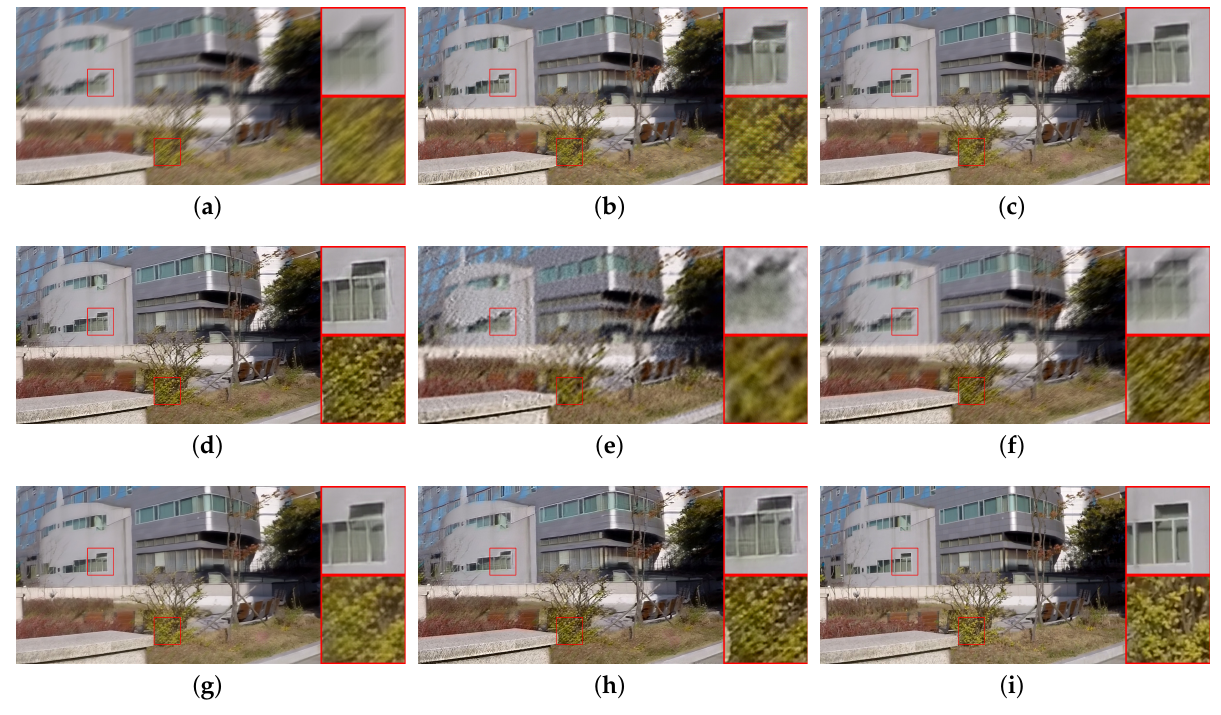
Figure 5. GoPro dataset test results. ( a ) Blur image; ( b ) DeblurGAN; ( c ) DeblurGAN-v2; ( d ) Self- Deblur; ( e ) UML-IN; ( f ) UML-IN + SSIM; ( g ) UML-IN + L 1; ( h ) UML-IN + L 1 + SSIM; ( i ) Ground Truth.